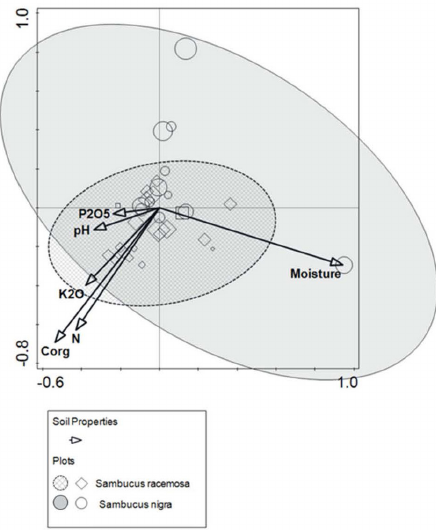
S. nigra (Figure 12).